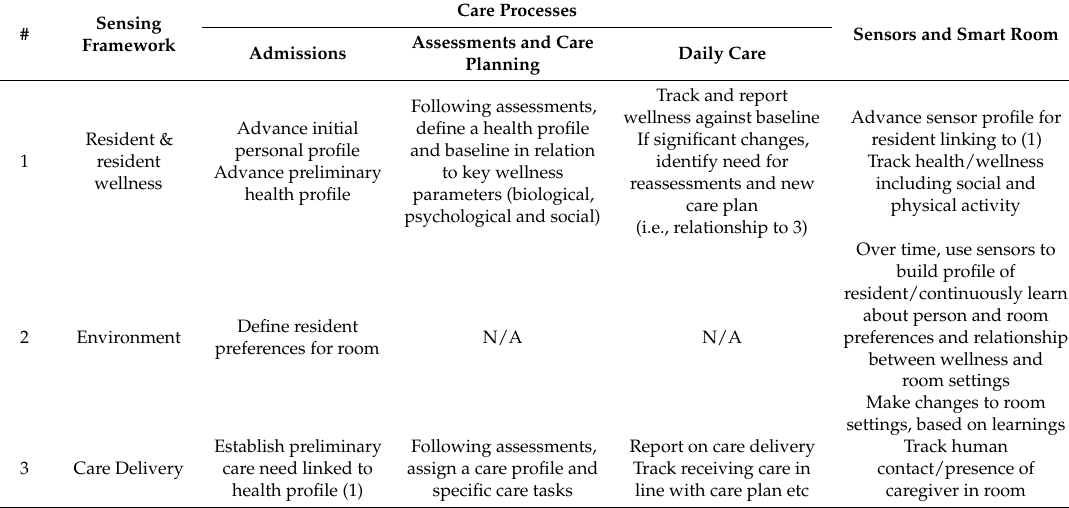
Table 3. Sensing framework and resident